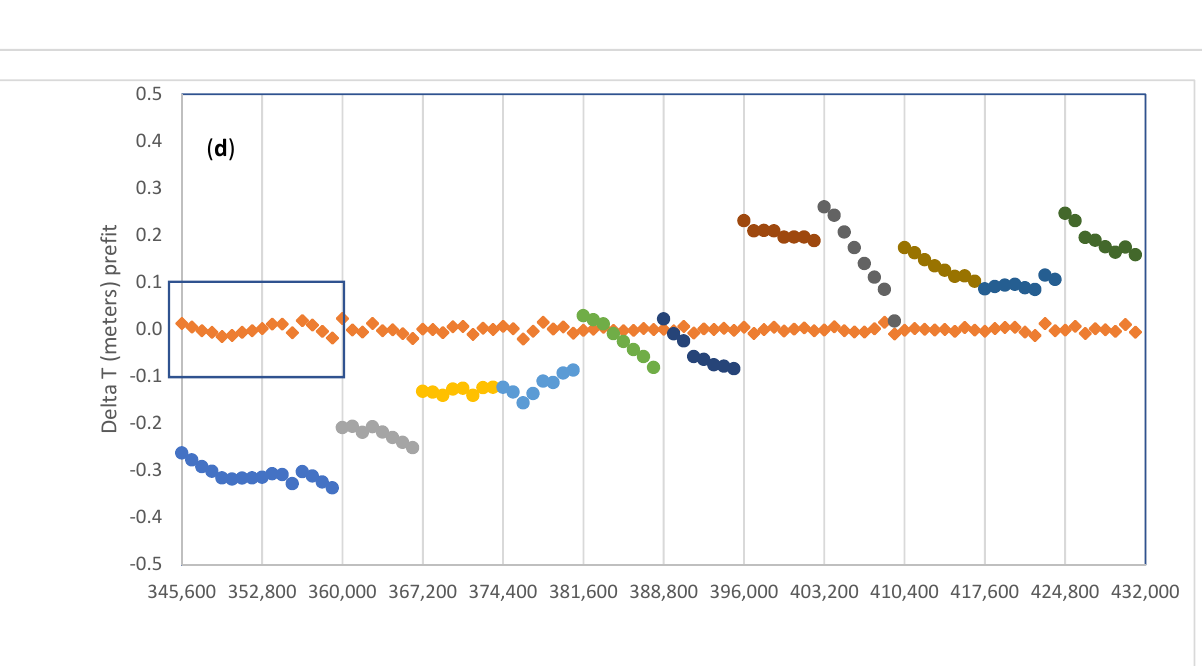
Figure 2. Pre-fit (dots: different colours for different ephemeris blocks) and post-fit (diamonds) residuals of ( a ) X, ( b ) Y, ( c ) Z, and ( d ) T for G01. Vertical line spacing is every two hours. The rectangle indicates a 4 h rather than 2 h arc. The residuals will be discussed in Section 4.